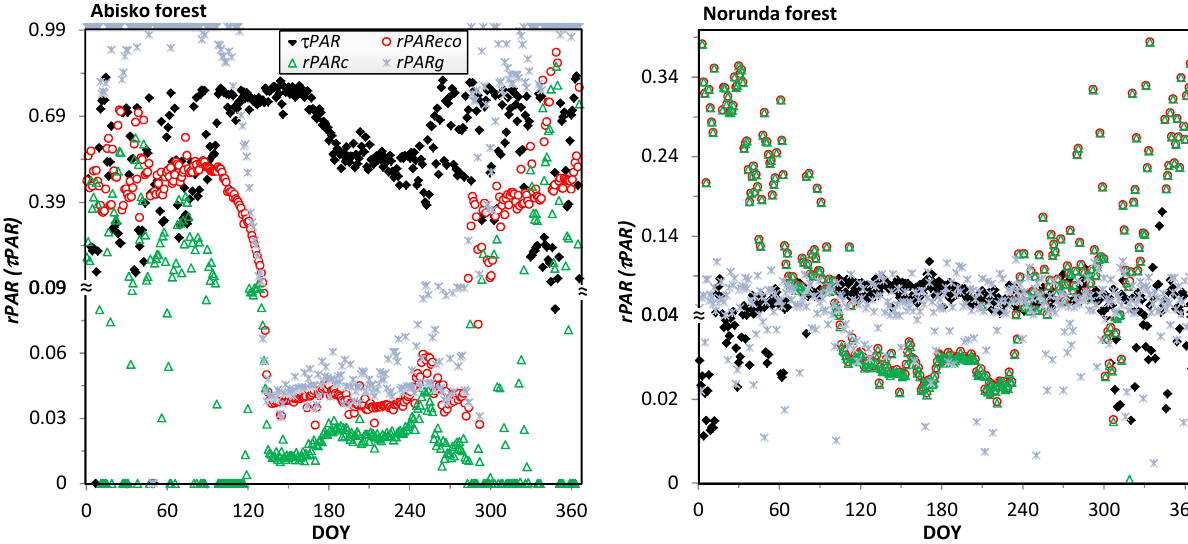
Figure 8. The annual courses of canopy PAR transmittance, ecosystem PAR reflectance, canopy PAR reflectance, and ground PAR reflectance at the Abisko (left) and Norunda (right) forests. Note the varied scale for the y-axis which is used to amplify the reflectance and transmittance changes during the growing season and transition periods snow-to-vegetation and